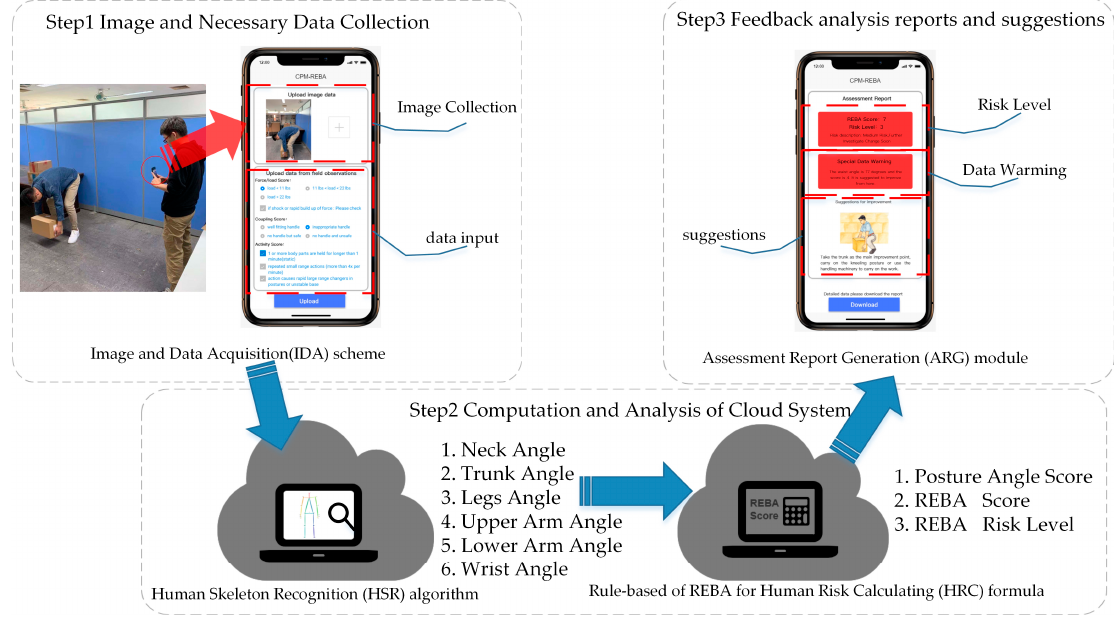
Figure 1. The system architecture of the Quick Capture system.